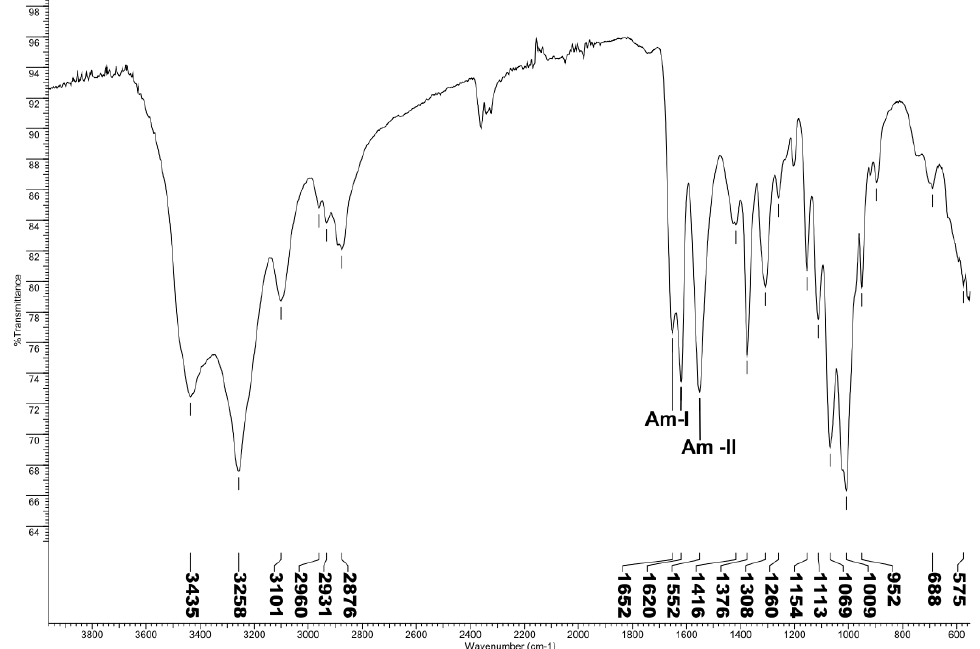
Figure 1. Fourier-transform infrared spectroscopy (FT-IR) spectrum data of chitin extracted